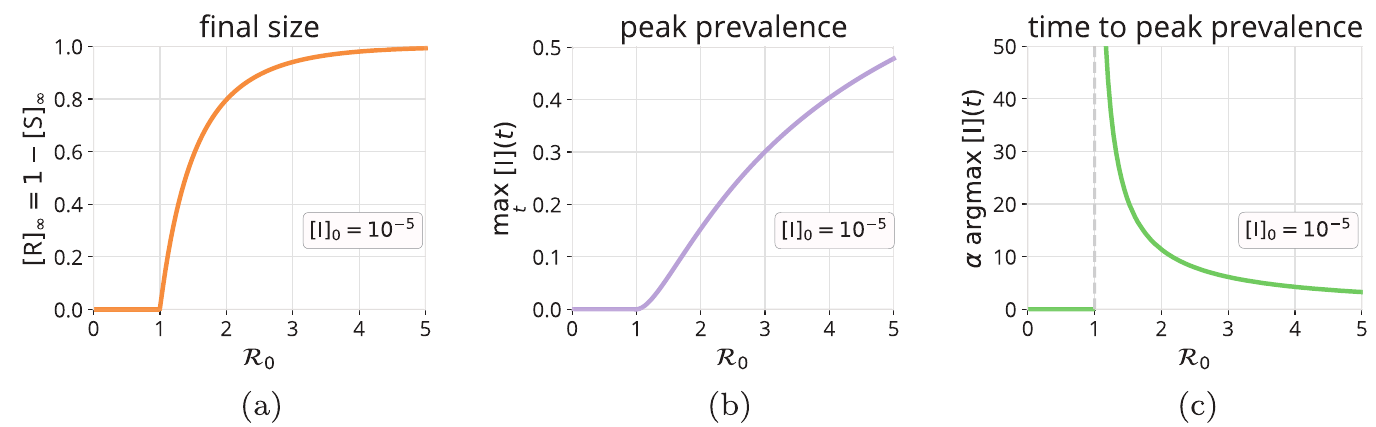
Figure 4 Final size and peak prevalence of an SIR epidemic. As a function of R 0 , (A) the fraction of the population that will be infected over the course of the epidemic, [R] ∞ = 1 − [S] ∞ , with [S] ∞ obtained from Eq. (11), (B) the fraction of the population that is infectious at peak prevalence, max t [I]( t ), via Eq. (12), and (C) the (non-dimensional) time to reach peak prevalence, argmax t a [I]( t ), computed by a grid search using the numerical solution to the SIR model. All correspond to initial conditions in Eqs. (6) –